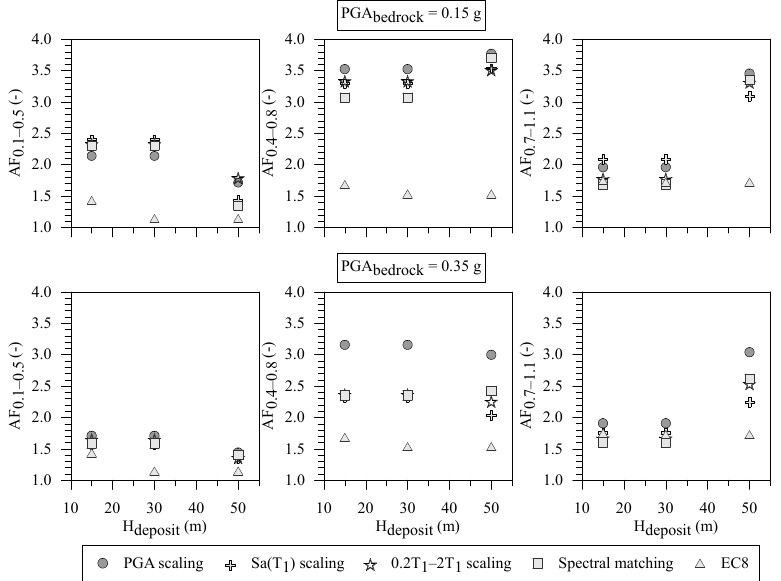
Figure 7. Mean values of AFs for a deposit thickness equal to 15, 30, and 50 m, and V S1 (z), considering 4 input motions selection strategies. EC8 values for 15, 30, and 50 m refer to ground types E, C, and C, respectively.